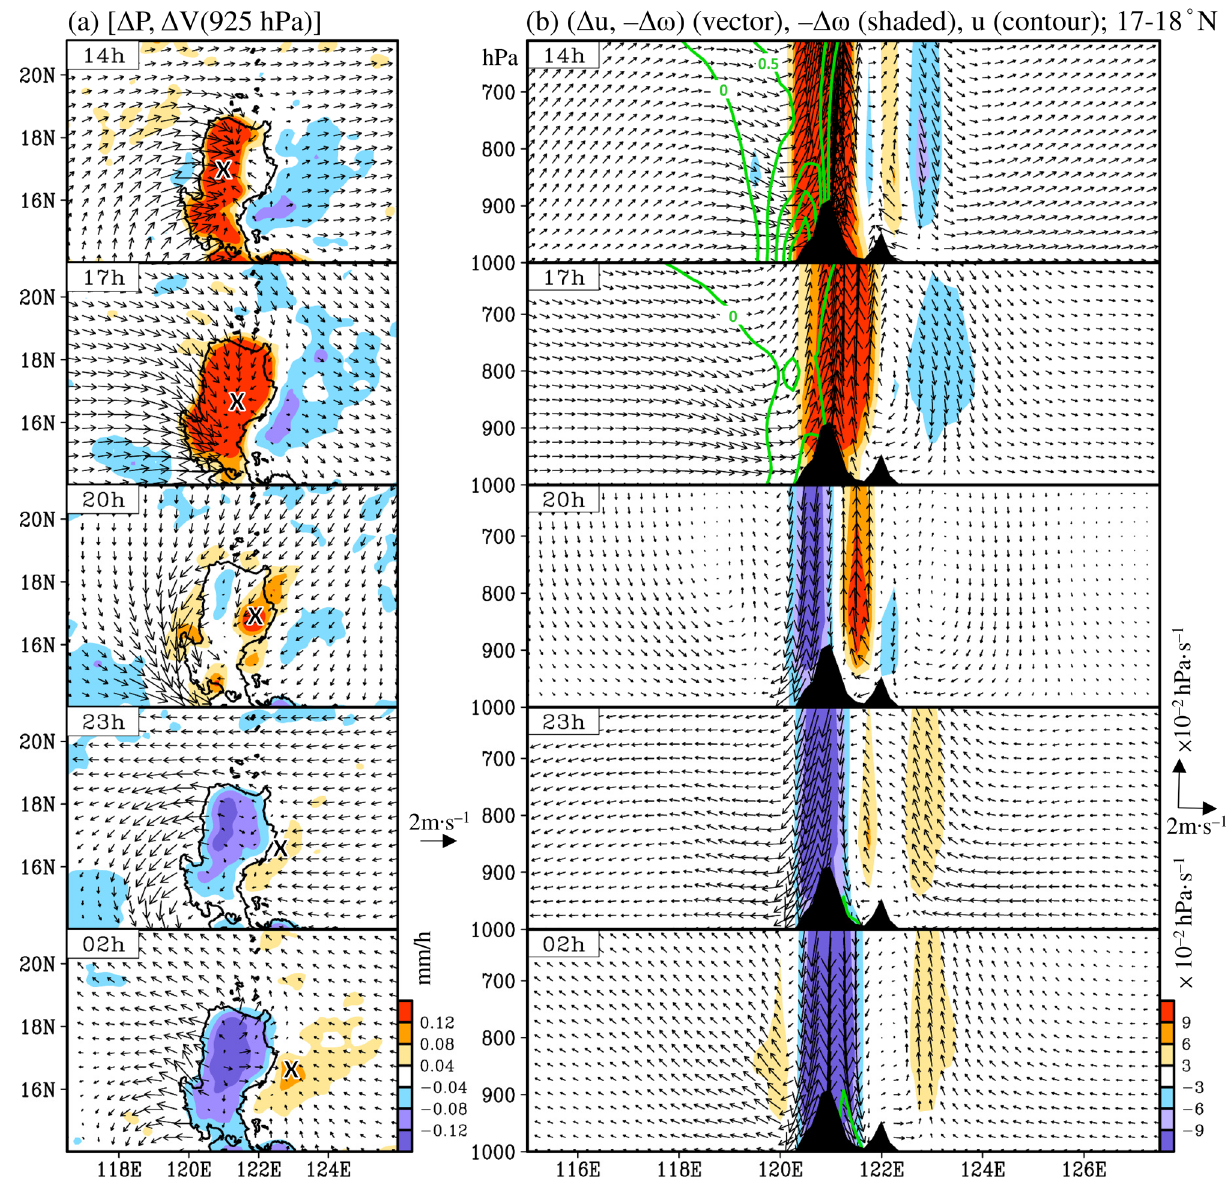
Figure 5. ( a ) Horizontal distribution of diurnal anomalies (daily mean removed, denoted as Δ) of precipitation (ΔP, shaded) extracted from IMERG superimposed with the low-level wind field at 925 hPa [ΔV (925 hPa), vector] extracted from ERA5 and averaged for spring from 2001–2019. The times (14–02 h) represent the local time in the Philippines. ( b ) is related to (a), but instead represents the vertical cross-section of the diurnal anomalies of longitudinal wind (Δu, horizontal vector) and vertical wind (− Δω, vertical vector) averaged over 17–18°N. In ( b ), the diurnal anomalies of the vertical velocity (− Δω; shaded) and the original longitudinal wind (u, only positive values of u are contoured; interval is 0.5 m/s) averaged over 17–18°N are added for additional clarity. The symbol “x” indicates the eastward propagation of diurnal precipitation. This figure is created using the software of GrADS